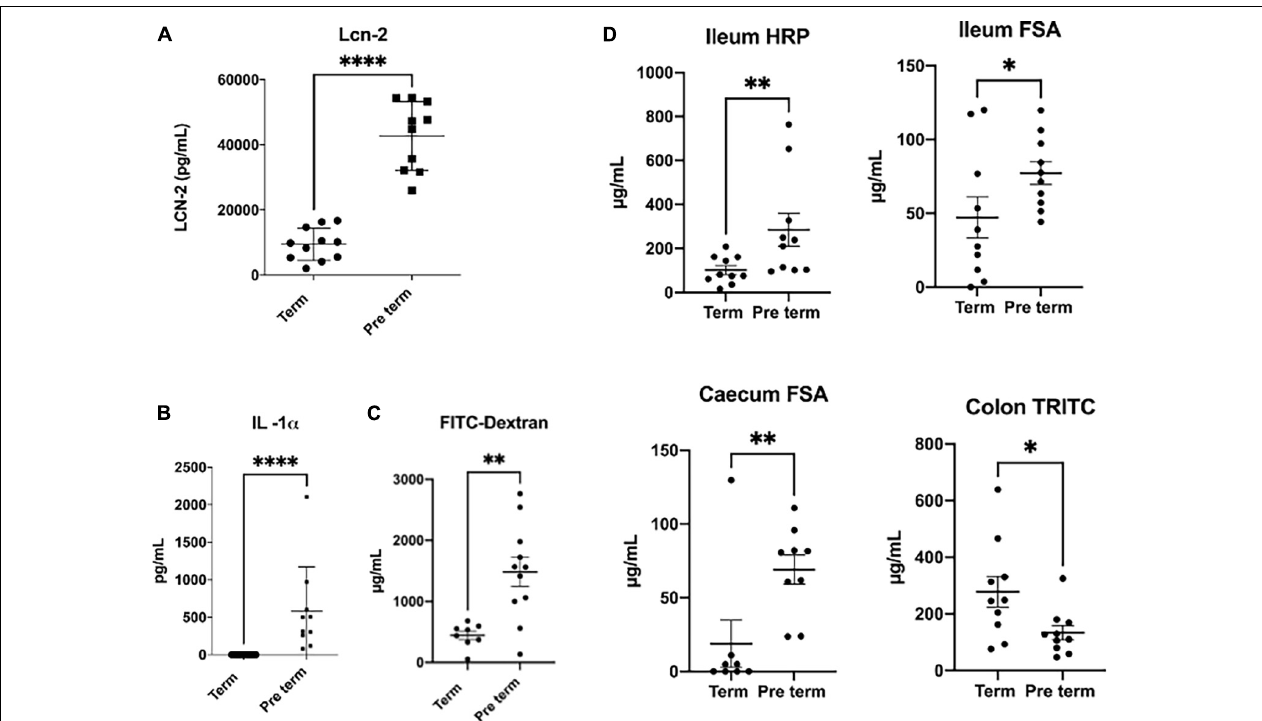
FIGURE 2 | Comparison of inflammation and permeability parameters. Comparison between spontaneous Swiss-CD1 preterm pups (born at 20 days of gestation) and Swiss-CD1 term pups (21 days of gestation) at weaning (3 weeks of age). Lipocalin 2 (LCN-2) concentration in serum, measured by Elisa (A) . Systemic permeability measured by doing gavage with the fluorescent molecule FITC-dextran (average size of 3,5 KDa) 3 h and a half before the euthanasia of the mice and measuring the fluorescence in blood in a spectrophotometer (B) . Serum concentration of IL-1 α measured by Biolegend plex (C) . Local permeability measured in Ussing chambers: ileum transcellular permeability measured by transfer of horseradish peroxidase (HRP), ileum paracellular permeability measured by sulfonic acid (FSA) passage and caecum and colon paracellular permeability measured by FSA or TRITC-dextran (TRITC) passage respectively (D) . n = 8-11, Man Whitney non-parametric test, ∗ p < 0.05, ∗∗ p < 0.01, ∗∗∗ p < 0.001, ∗∗∗∗ p <